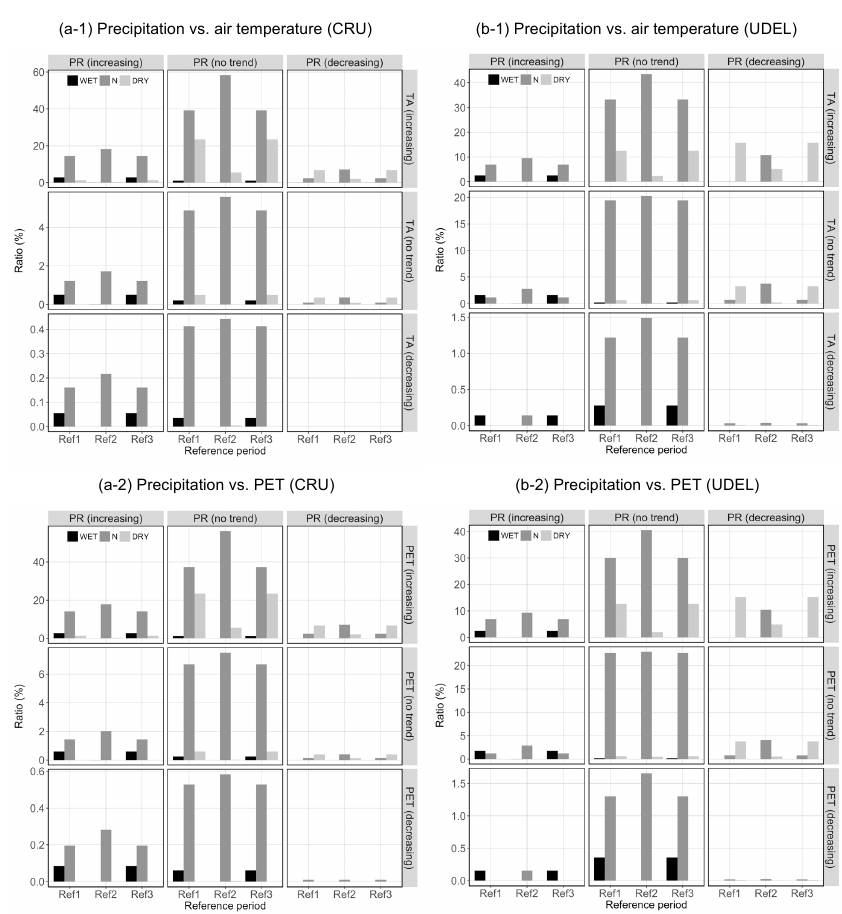
Figure 8. The ratios of SPEI-12 trends in three different reference periods (Ref1, Ref2 and Ref3 in Table 2) based on the CRU and UDEL datasets for trends of monthly precipitation and temperature (or potential evapotranspiration) in each region. For the SPEI, WET, N and DRY indicate a statistically positive (wetting) trend, no trend and a negative (drying) trend, respectively, at a significance level of 5%. Trends of precipitation, air temperature and potential evapotranspiration are grouped into three with a statistically increasing (positive) trend, no trend and a decreasing (negative) trend at a significance level of